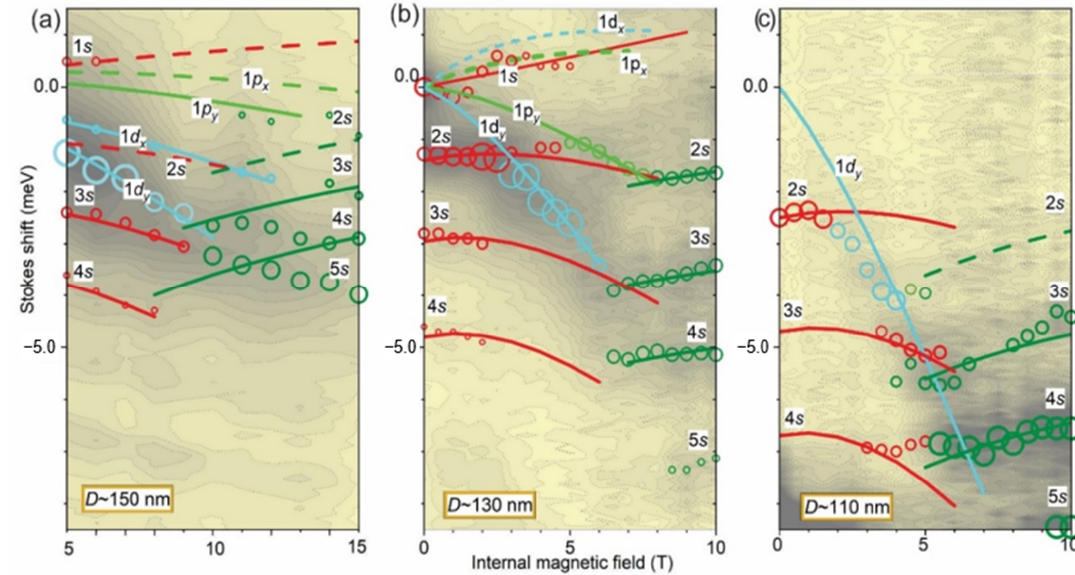
Figure 5. Contour plots of PL spectra of S04 ( a ), S11( b ) and S12 QDs ( c ), peak positions (circles) and their Fock-Darwin spectra fit using Equation (3) versus internal magnetic field B = B e + B bi